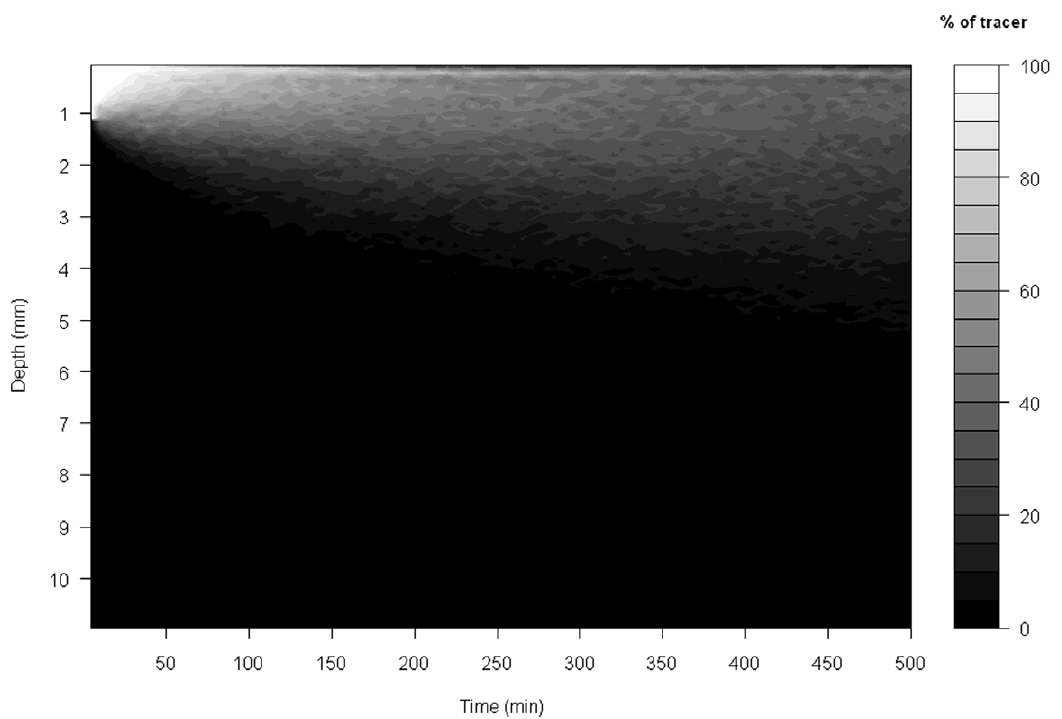
Figure 4. Visualisation of the predicted distribution of tracer particles (luminophores) assuming a purely diffusional form of redistribution. Grey shades denote the predicted relative density of luminophores at a given depth and time point.